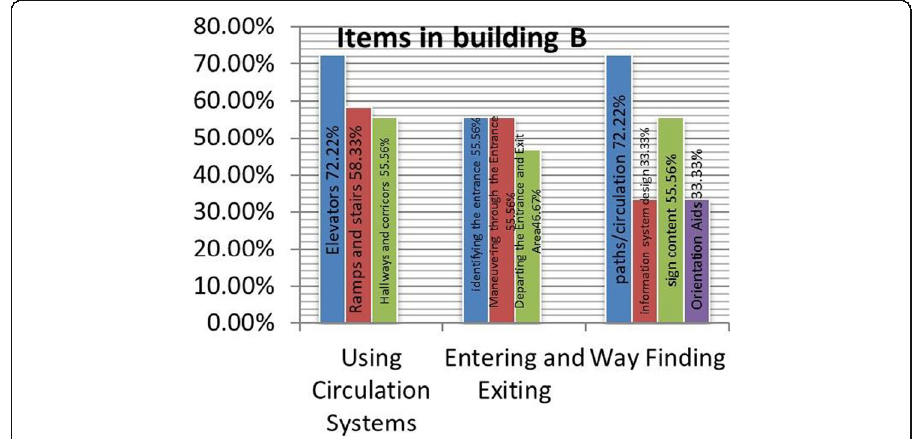
Fig. 21 Percentage of compliance to UD for the elements in building B